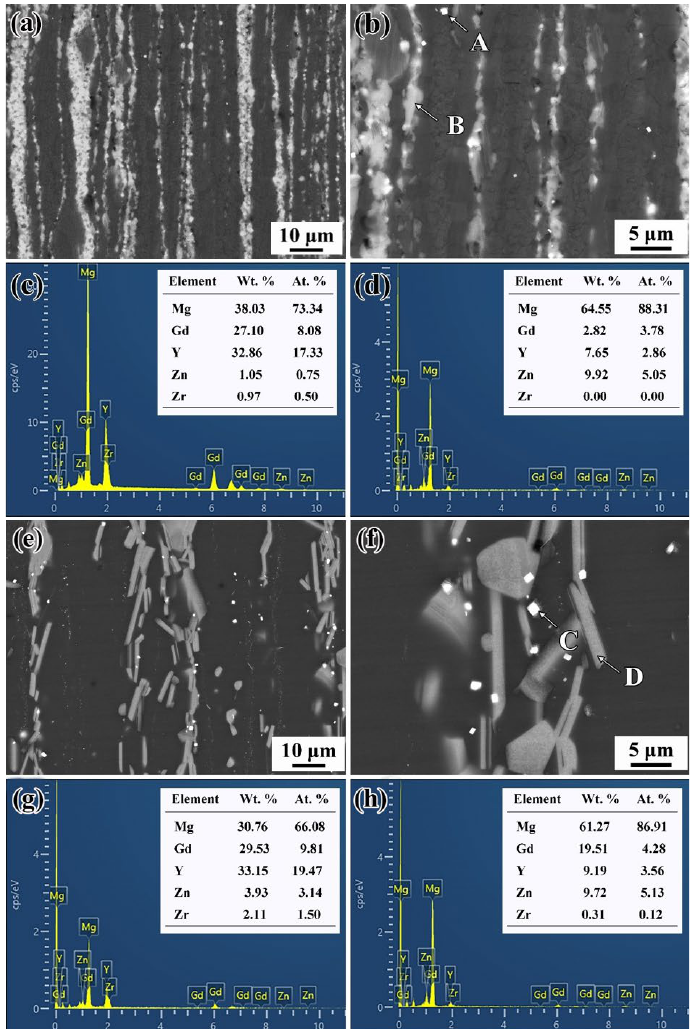
Figure 4. SEM and EDS analysis of the Mg-11.46 Gd-4.08Y-2.09Zn-0.56Zr alloy: ( a , b ) SEM results of T5-treated alloy; ( c , d ) EDS results corresponding to A and B in ( b ); ( e , f ) SEM results of T6-treated alloy; ( g , h ) EDS results corresponding to C and D in ( f ).